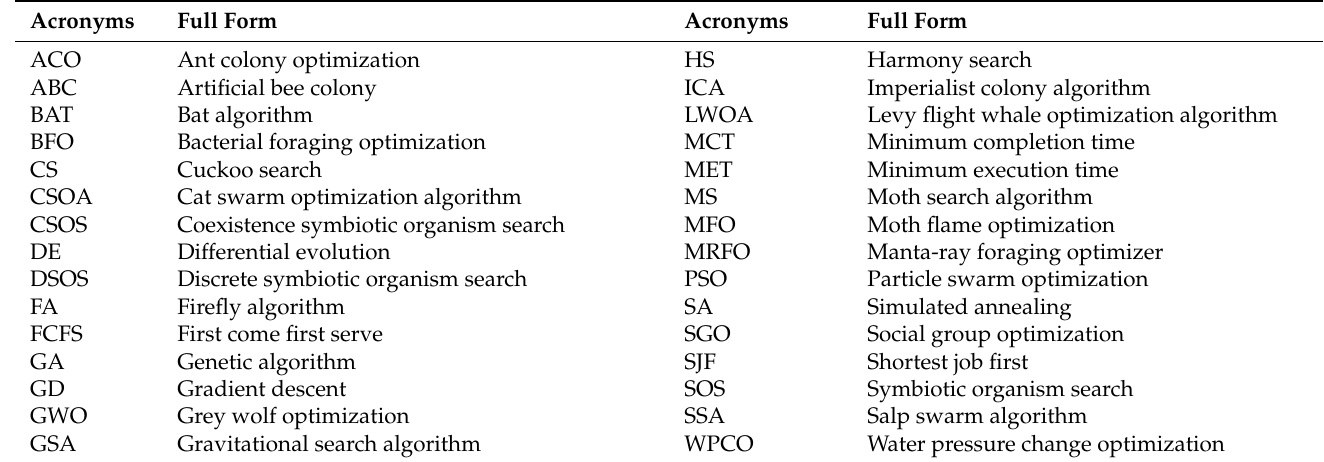
Table 1. List of